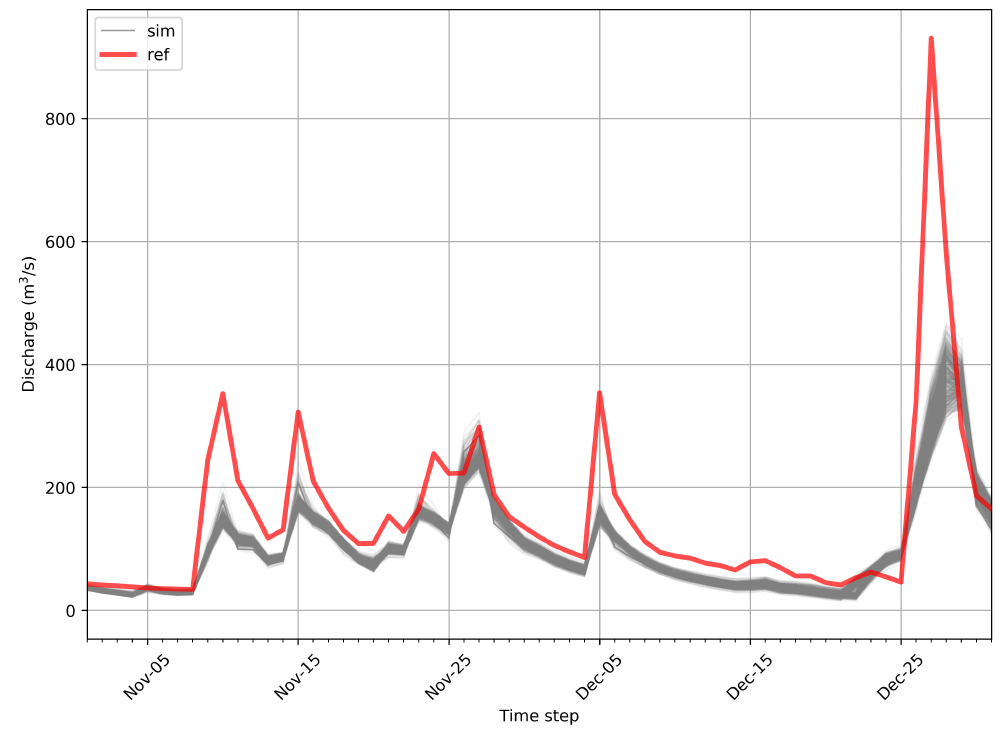
Figure 5. Observed (red) and calculated (gray) discharges for November and December 1882 using parameters from the present calibration period.